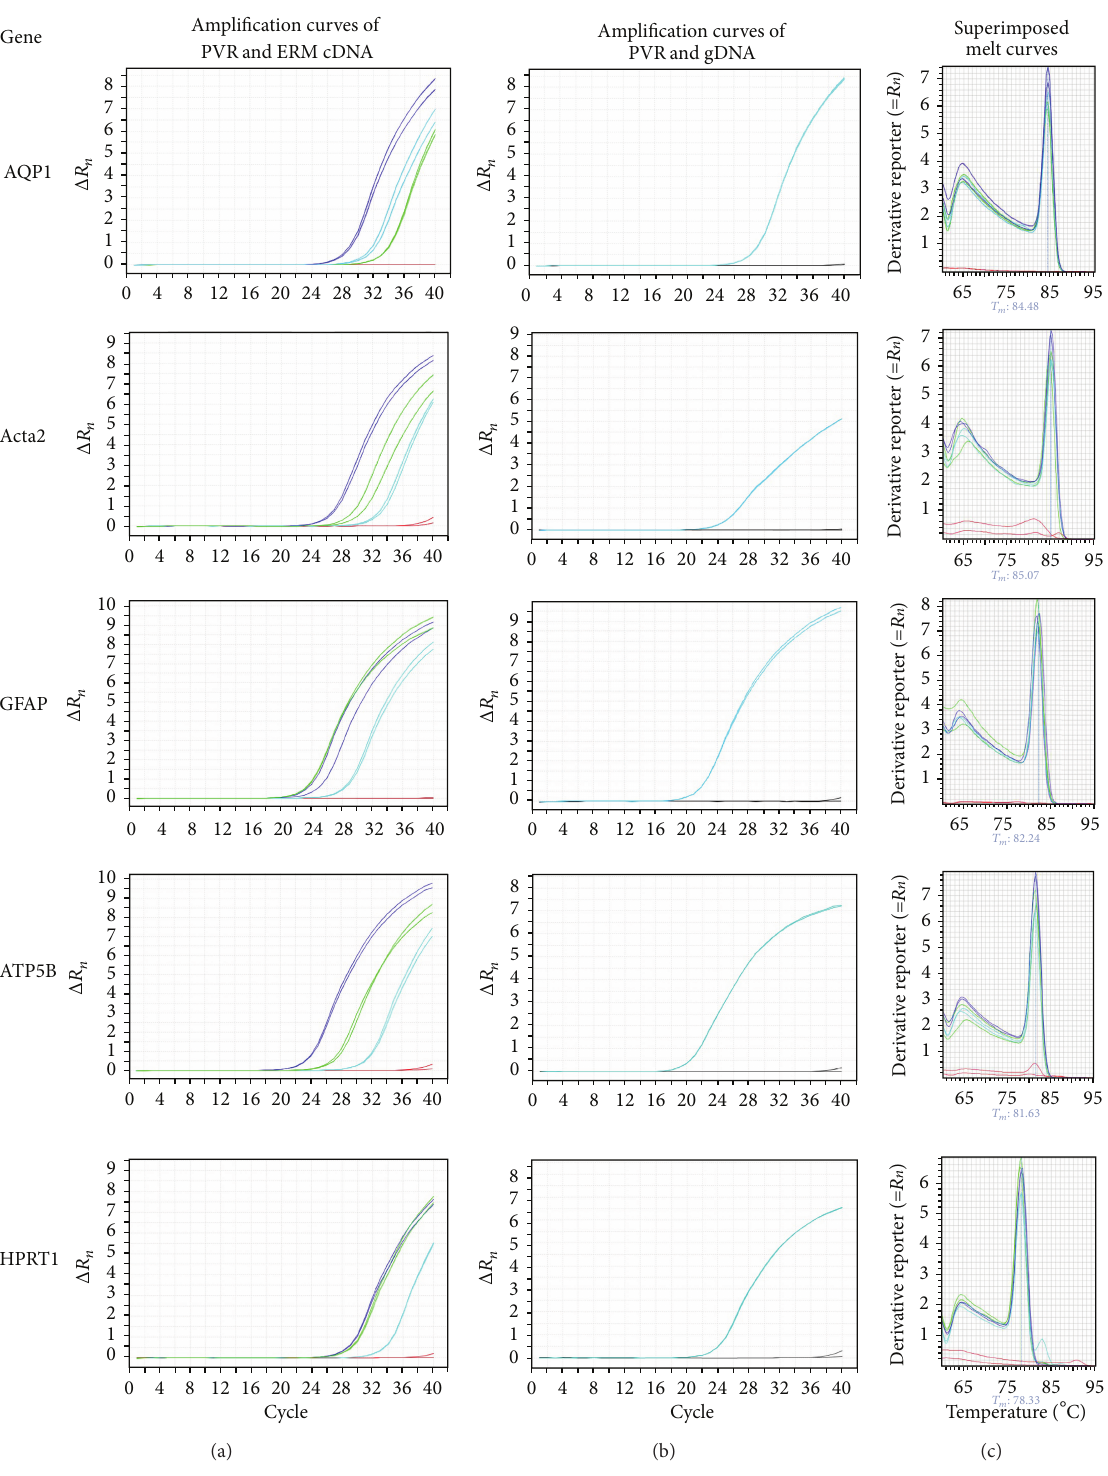
Figure 1: AQP1 mRNA expression in membranes from PVR and ERM. First Column: cDNAs from pools of 3 PVR membranes or 6 ERM membranes were used for RT-qPCR. The amplification curves obtained with cDNA from a positive control (mallow curve), a negative control (red curve), PVR (green curve), and ERM (light blue curve) are shown for each tested gene. Second Column: RT-qPCR amplification curves obtained with cDNA from a positive control (light blue curve) or 2.5 ng genomic DNA (gDNA) (black curve) are shown for each tested gene primers. Third Column: RT-qPCR melt curves obtained following 40 RT-qPCR cycles and with cDNA from a positive control (mallow curve), PVR (green curve), and ERM (light blue curve) or genomic DNA (red curve) are shown for each tested